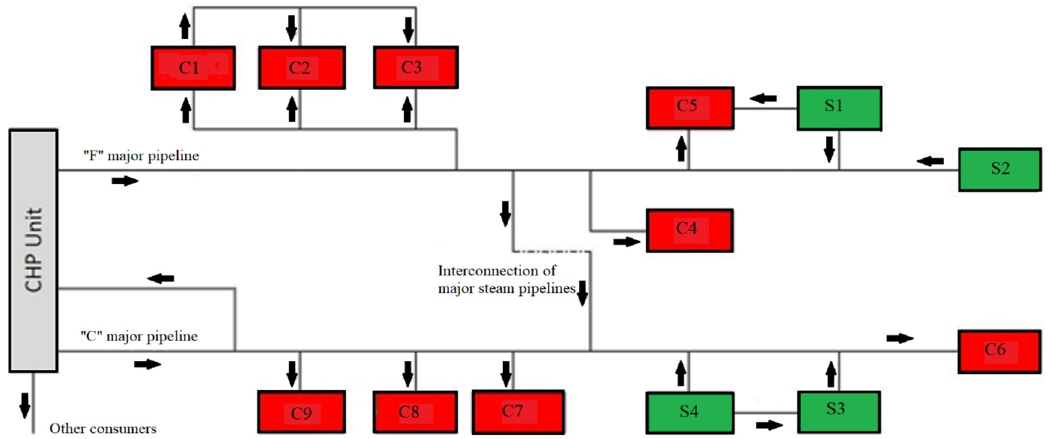
Figure 1. A part of simplified simulation scheme of high-pressure steam (HPS) network for the balance model (S = steam supplier, C = steam consumer).